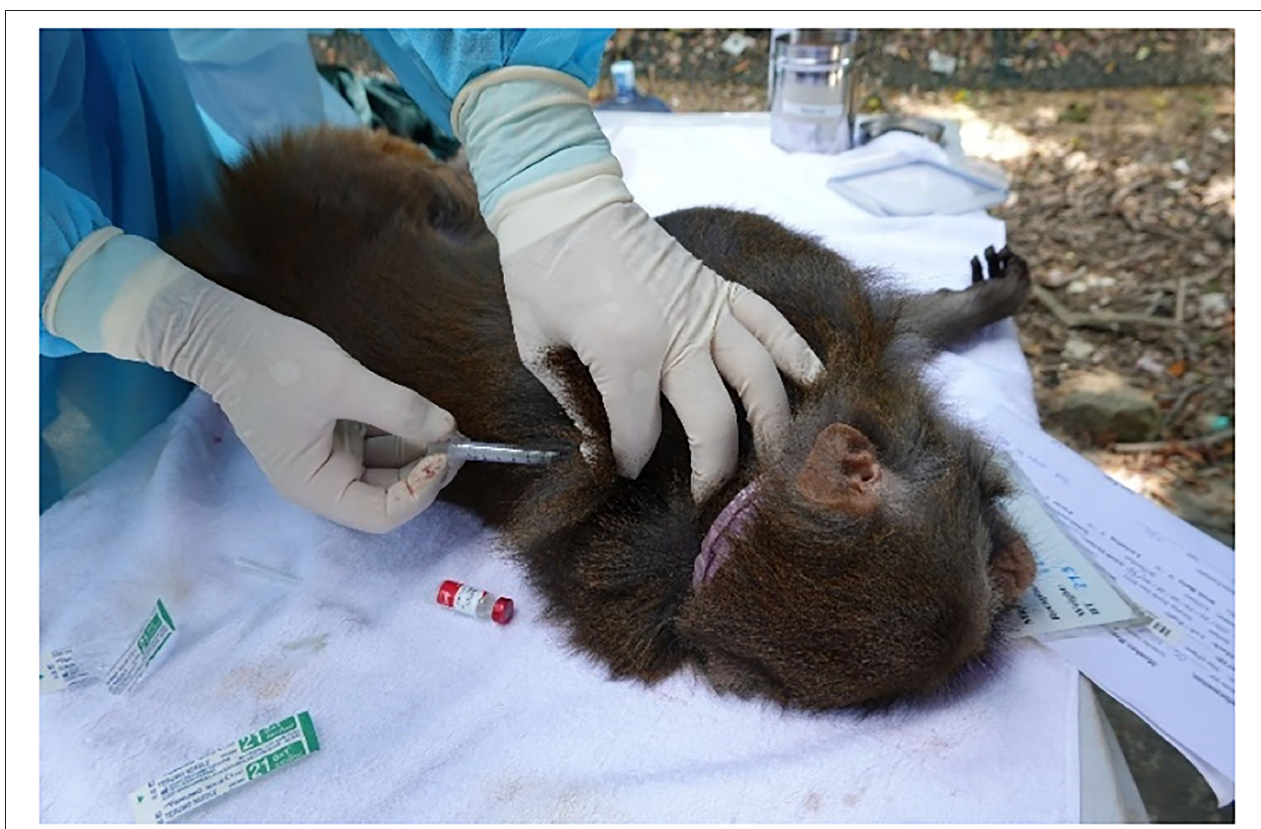
FIGURE 2 | Subcutaneous injection of the rabies vaccine (1ml) in the interscapular space of a Hong Kong macaque under anesthesia, using a 3ml syringe and a 23-gauge